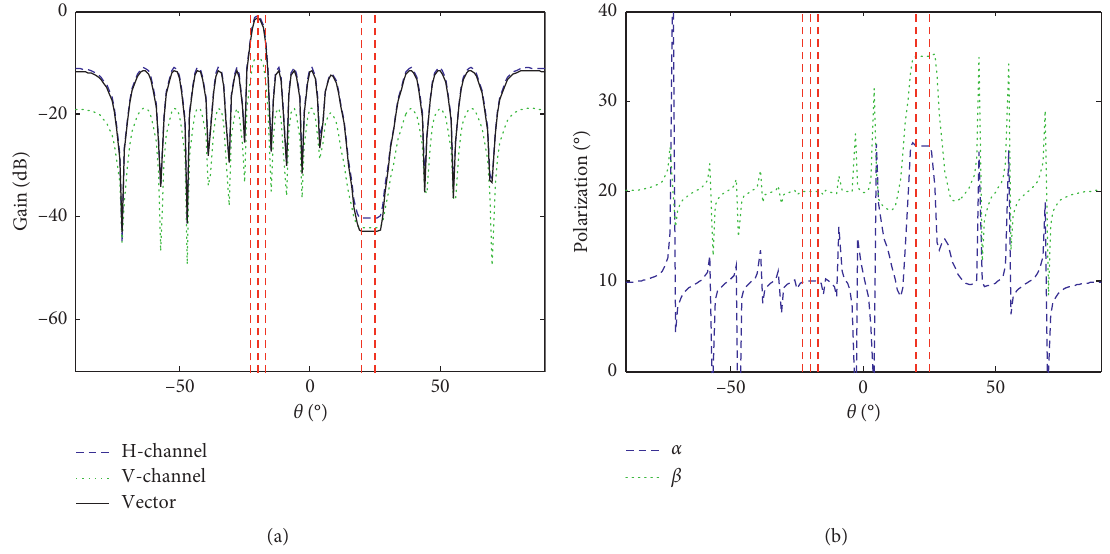
Figure 6: Proposed method of polarized beampattern. (a) Beampattern. (b)